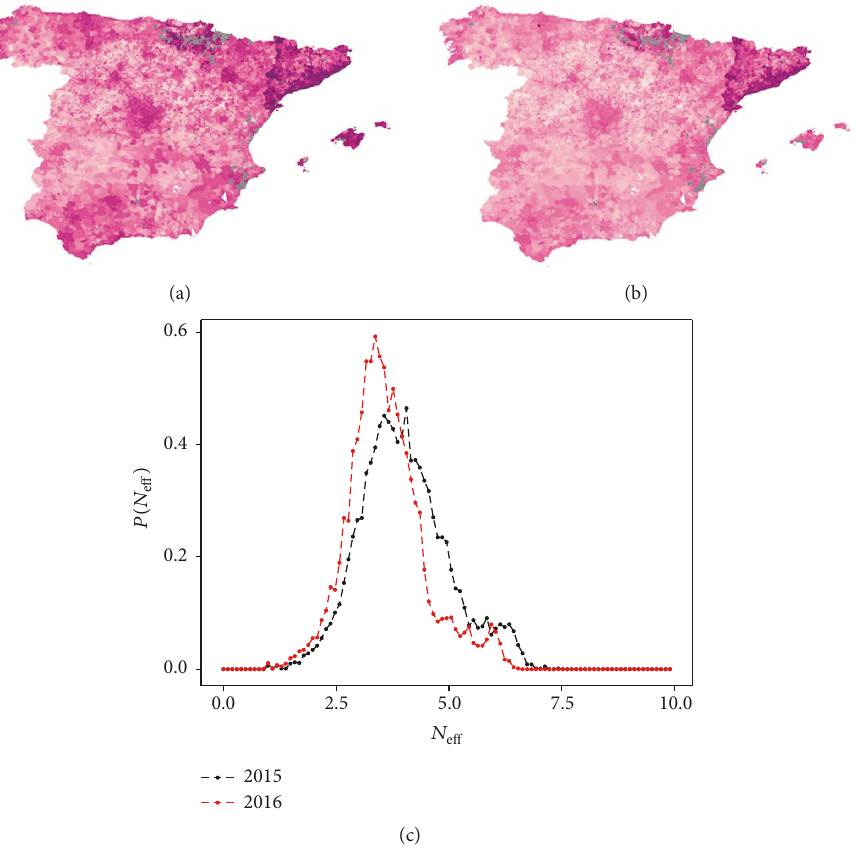
Figure 4: (a, b) Heat map of the diversity index ( 𝑁 eff , see the text) at the municipality level (the darker and the larger 𝑁 eff is, the less bipartisan the system is) for 2015 elections (a) and 2016 elections (c). One can see that overall the system is more diverse in 2015 and its diversity decreases in 2016. This result is in consonance with bipartisanship breakdown stalling, probably due to risk aversion that generates the uncertainty associated with not obtaining workable majorities in parliament. (c) Frequency histogram of 𝑁 eff for 2015 and 2016, highlighting an initially diverse voting ecosystem with ⟨𝑁 eff ⟩ = 4.1 (over four relevant parties on average) in 2015, and a clear shift towards a smaller diversity in